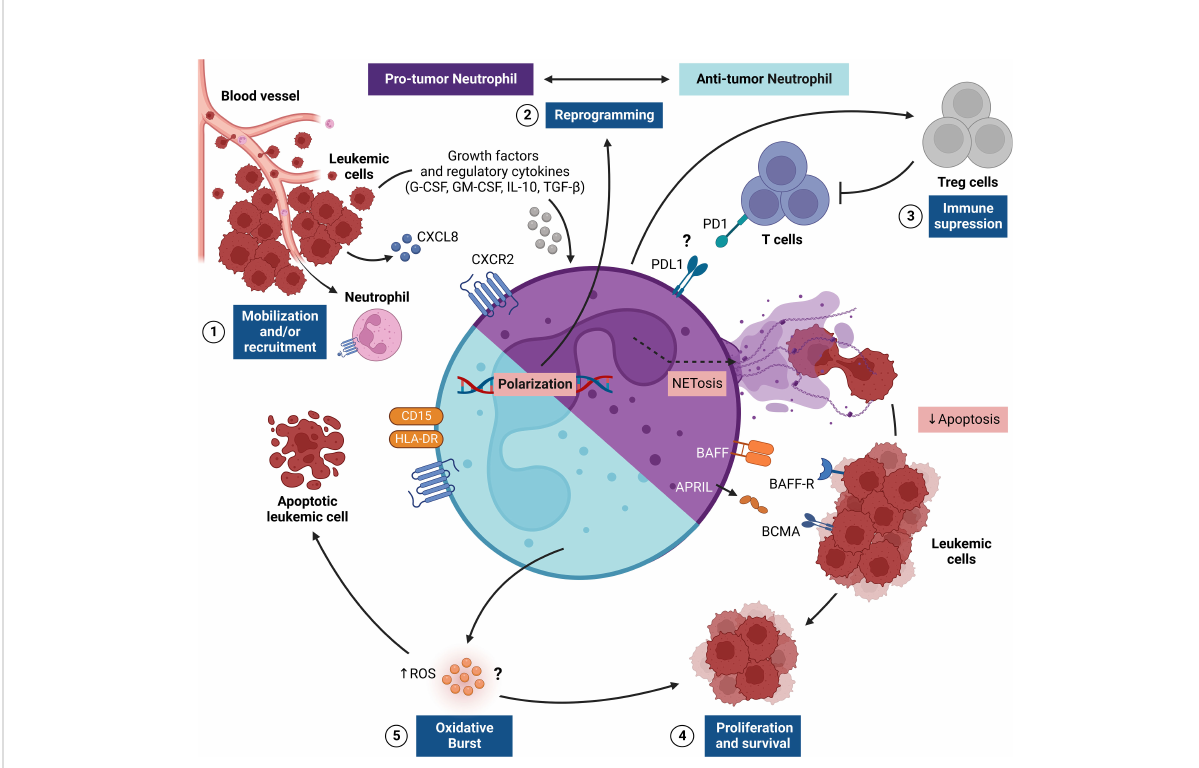
FIGURE 1 Regulation of TAN responses in the leukemic microenvironment. The fi gure shows the pro-tumor and antitumor activities of tumor-associated neutrophils (TANs), which provide critical signals for leukemic progression. This network of interactions between TANs, leukemic cells (LCs) and other immune cells [e.g., regulatory T cells (Treg)] results in four main events: [1] recruitment and/or mobilization of neutrophils via CXCL8/ CXCR2 to the leukemic microenvironment, where LCs promote the survival of TANs through the release of G-CSF and GM-CSF; [2] reprogramming of TANs to become pro-tumor (N2) or antitumor (N1) cells through stimulation of the leukemic microenvironment through the cytokines IL-10 and TGF- b ; [3] immunosuppression promoted by N2 TANs that can preferentially recruit Treg cells and can suppress T cell effector responses, apparently via a PD1-PDL1-mediated pathway; [4] LC proliferation and survival in the leukemic microenvironment regulated by a range of surface molecules (e.g., BAFF and APRIL) expressed by N2 TANs, which also release NETs, which, in turn, delay LC apoptosis; [5] In another scenario, the oxidative burst triggered by N1 TANs can promote the release of reactive oxygen species (ROS) that control proliferation or mediate the killing of LCs. APRIL, A proliferation-inducing ligand; BAFF, B-cell activating factor; G-CSF, granulocyte colony-stimulating- factor; GM-CSF, Human granulocyte-macrophage colony-stimulating factor; NETs, Neutrophil extracellular traps; PD1, Programmed cell death protein 1; PDL1, Programmed cell death-ligand 1; TGF- b , Transforming growth factor- b